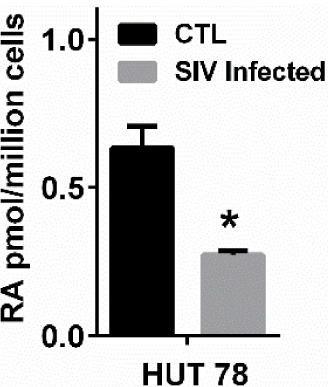
Figure 3. Effects of acute SIV infection and anti- α 4 β 7 antibody treatment on RA production and ILC3 frequency in NHP . NHP (Rhesus macaques) were infected with SIV at week 0 and treated with daily anti-retroviral therapy (ART) and control IgG ( n = 7) ( A ) or ART and anti- α 4 β 7 antibody ( n = 8) ( B ) over the post-infection treatment periods indicated by the black arrows. ( A ) The ART/IgG regimen showed a rapid decrease in RA levels (blue) along with a decrease in the mean frequencies of ILC3 cells (red). ( B ) The ART/anti- α 4 β 7 antibody regimen resulted in a recovery of plasma RA levels by week 15 (blue) equivalent to the pre-infection values that was accompanied by an expansion of the ILC3 cells (red). The ILC3 were obtained from the gated population of CD3 − /CD8+/HLA- DR+/NKG2a − /NKp44+ cells in samples of colorectal tissue-isolated mononuclear cells from 3 rep- resentative animals from each group. RA levels (mean ± SEM) were quantified by LC-MS/MS and compared with pre-infection (week 0) values (* p < 0.05). Adapted from Byrareddy SN et al., 2016 [61].